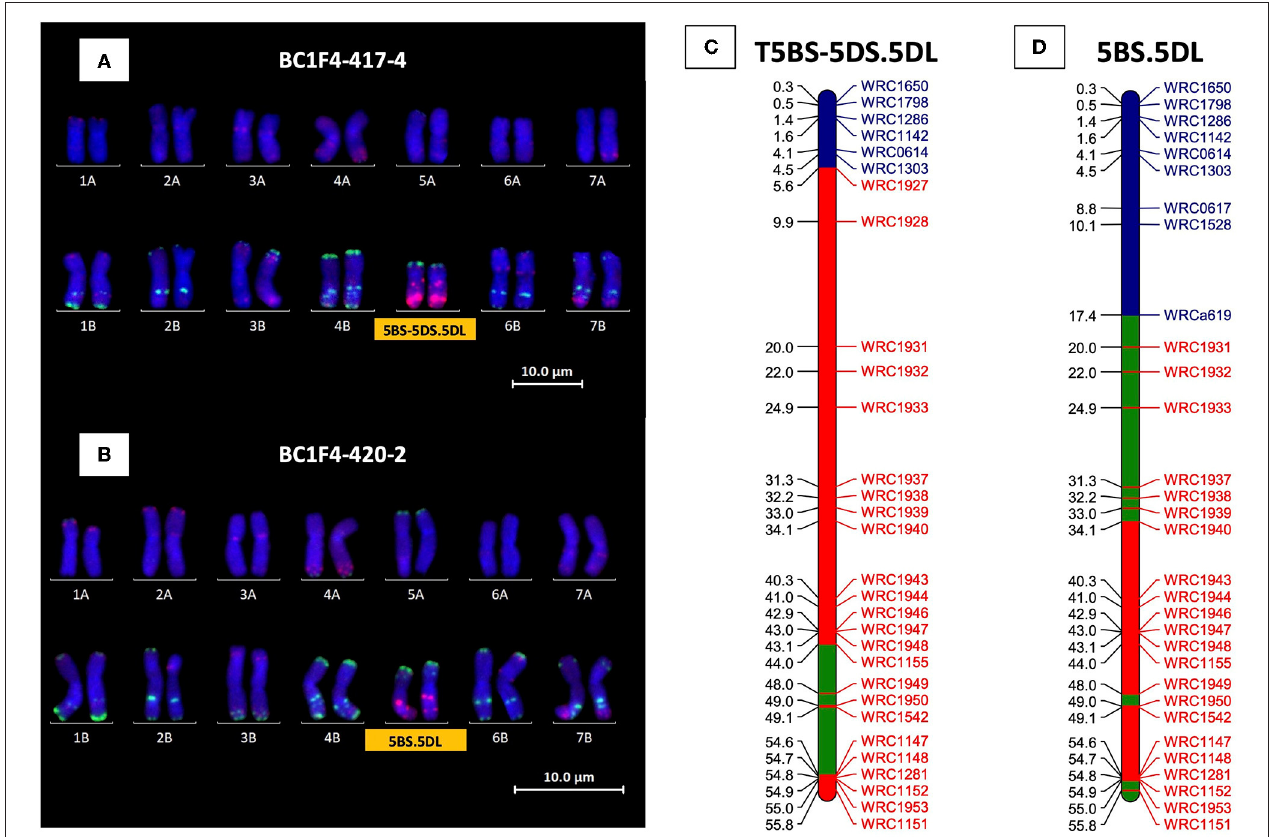
FIGURE 7 | Mc-FISH-based karyotype using the Oligo-pAs.1 (red) and Oligo-pSc119.2 (green) probes counterstained with DAPI (blue) of the D-genome homozygous introgression lines (A) BC 1 F 4 -417-4 and (B) BC 1 F 4 -420-2 shown in the presence of T5BS-5DS.5DL and 5BS.5DL translocation, respectively, confirmed by the amplification of the specific KASP markers of 5BS (markers name in blue) and 5DL wheat/ Ae. tauschii polymorphic (markers name in red) for (C) T5BS-5DS.5DL and (D) 5BS.5DL, respectively. The retained segments from 5B and 5D of wheat and 5D of Ae. tauschii are highlighted in blue, red, and green,